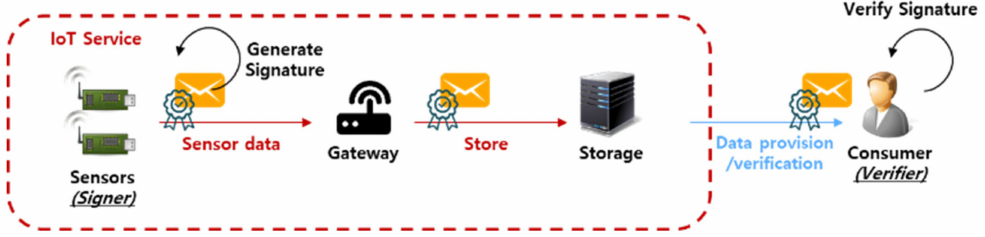
Figure 1. Data signing and verification scenario in an Internet of things (IoT)